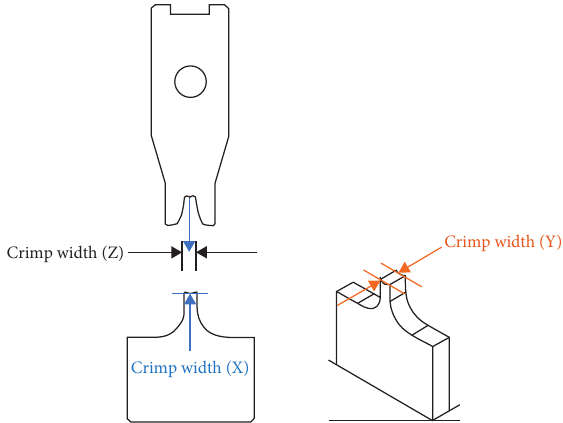
Figure 3: Crimpers and Anvil for crimping assembly.